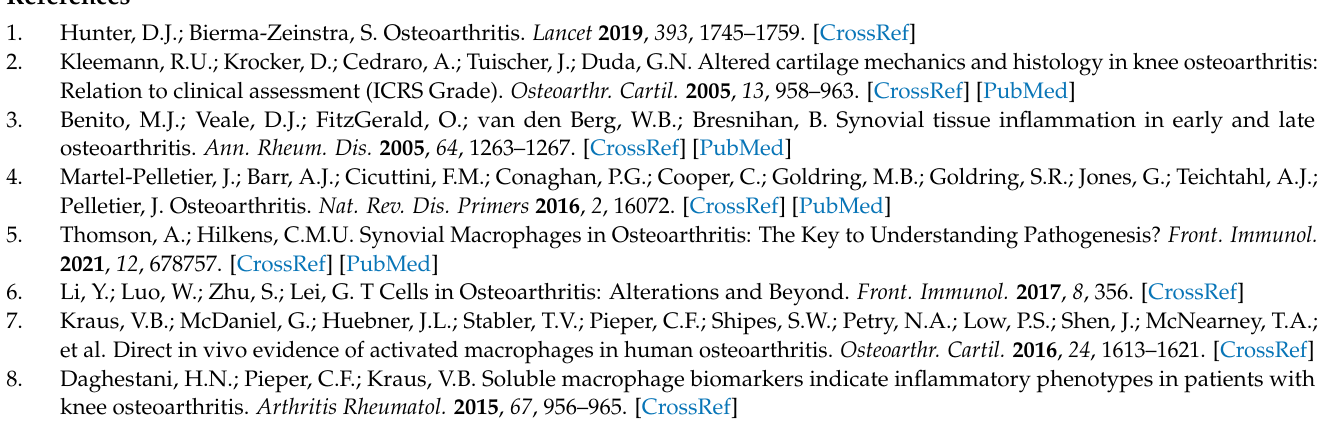
Table S4: miRNAs detected in SF-treated BMSC-EVs; Table S5: First quartile BMSCs EV-miRNAs targets; Table S6: Univocal miRNA-mRNA